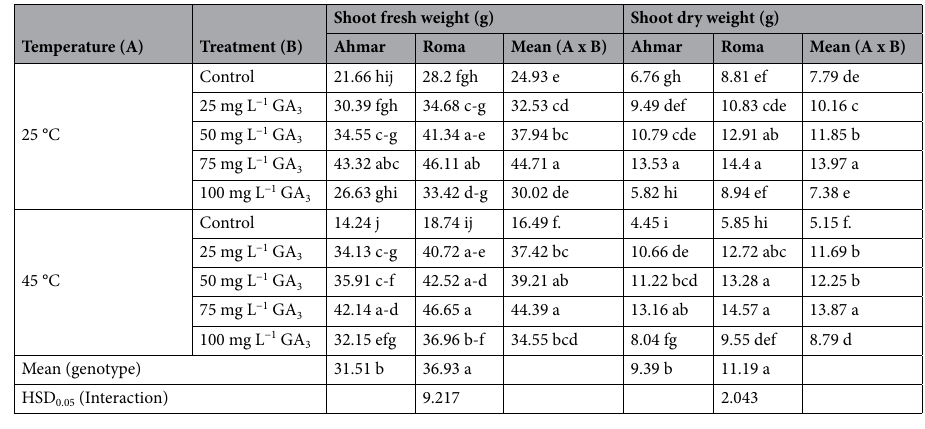
Table 2. Shoot fresh and dry weight of tomato as affected by temperature, genotype and exogenous application of GA 3 . According to Tukey’s honestly significant difference test, the same letters suggest that there is no statistically significant difference between treatments ( p ≤ 0.05).